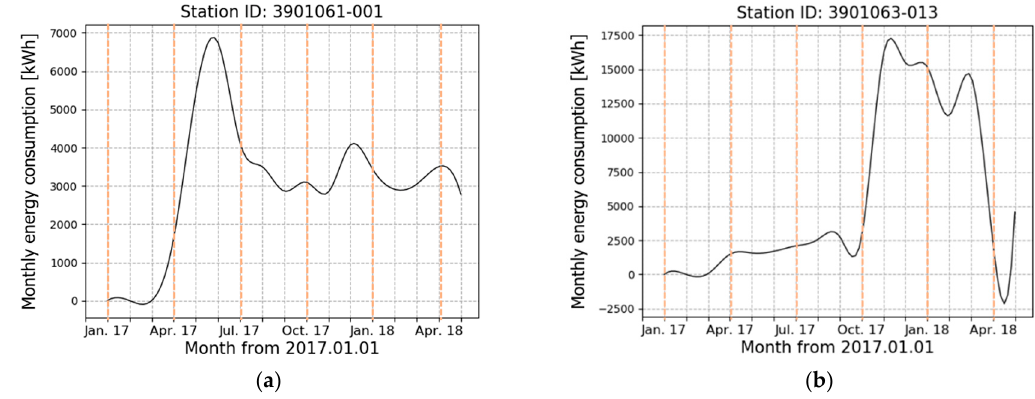
Figure 5. A graph of monthly electricity consumption change over time. Station ID: ( a ) 3901061-001; ( b ) 3901063-013.